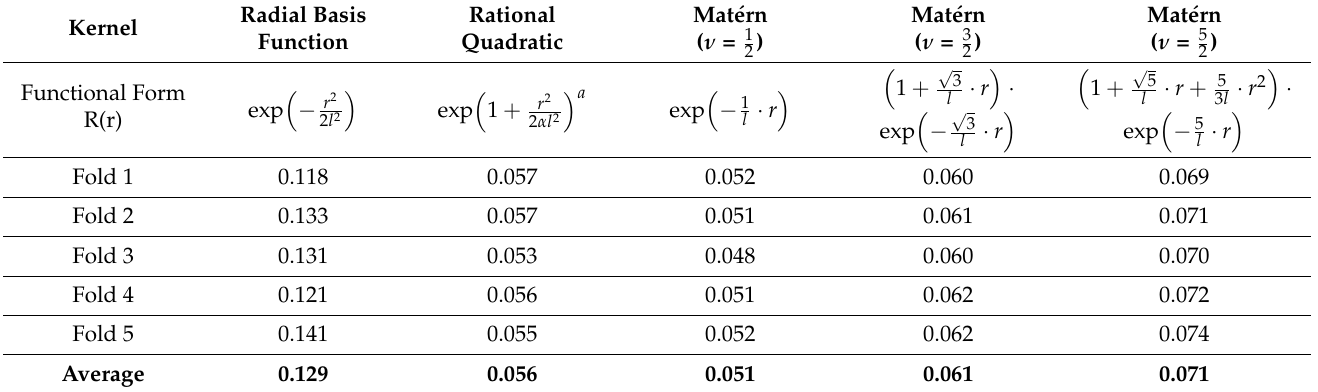
Table 2. Five-fold cross-validation results for all tested covariance